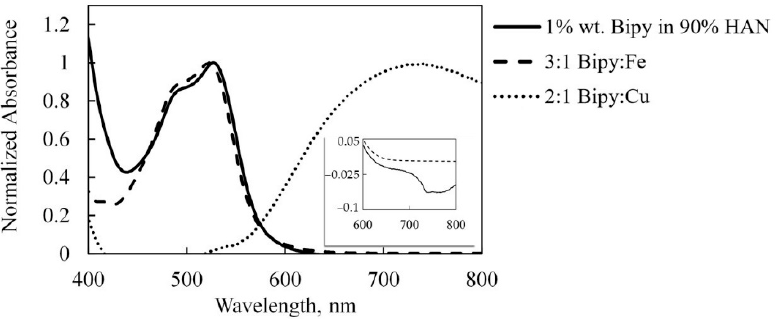
Figure 12. Comparison of absorbance spectra of 1% w/w Bipy in 90% HAN to samples of Bipy+Fe and Bipy+Cu in nitric acid solution, normalized to the peak absorbance for comparison of peak wavelength values.